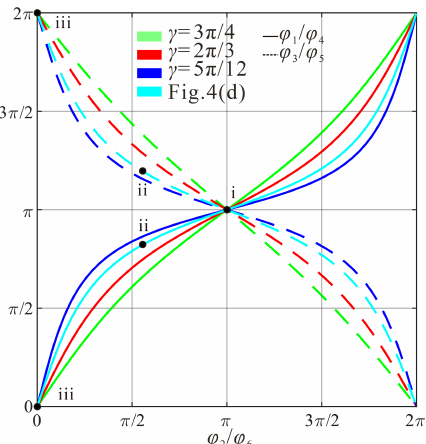
Figure 5. The kinematic curves for scheme I among upper-dihedral angles ϕ 1 , ϕ 3 , ϕ 4 , ϕ 5 vs. ϕ 2 ( ϕ 6